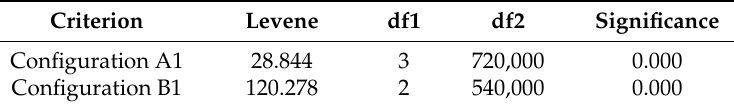
Table 16. Variance homogeneity test result of battery output power.